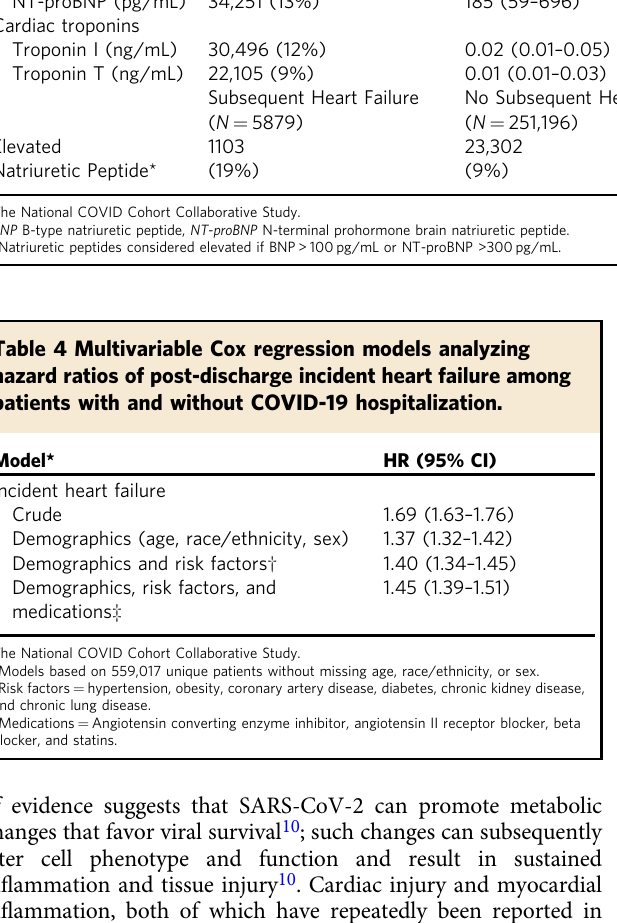
Table 3 Cardiac biomarkers assayed at index hospitalization for patients with and without COVID-19 infection. Biomarker laboratories COVID-19 Hospitalization ( N = 257,075)